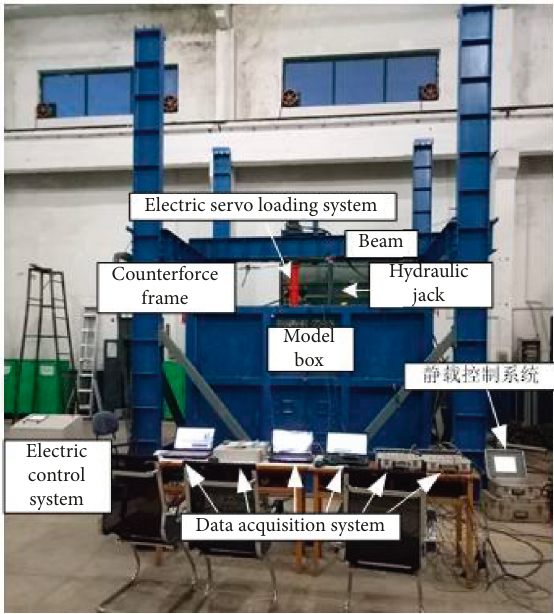
Figure 1: Large model test